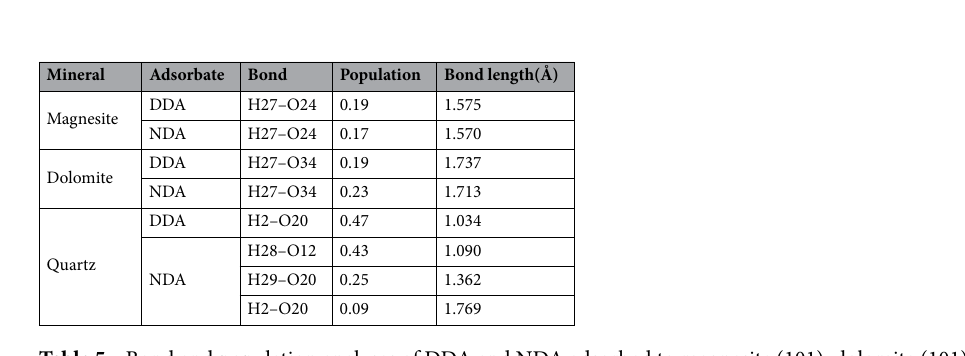
Table 5. Bond and population analyses of DDA and NDA adsorbed to magnesite (101), dolomite (101) and quartz (101) surfaces.